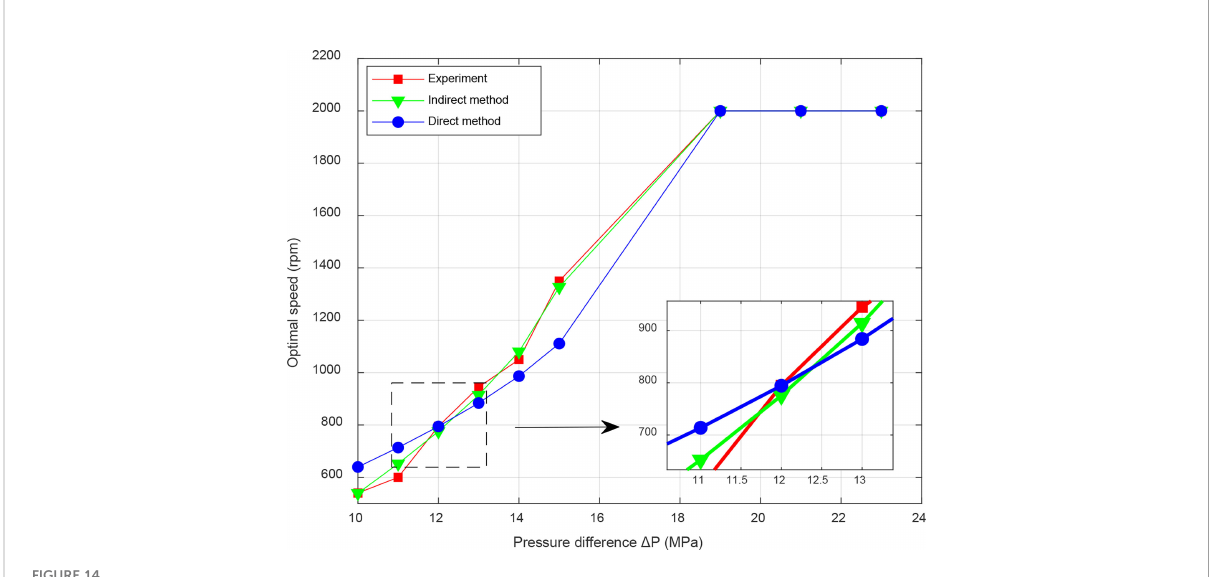
FIGURE 14 The simulation and experimental comparison of the optimal